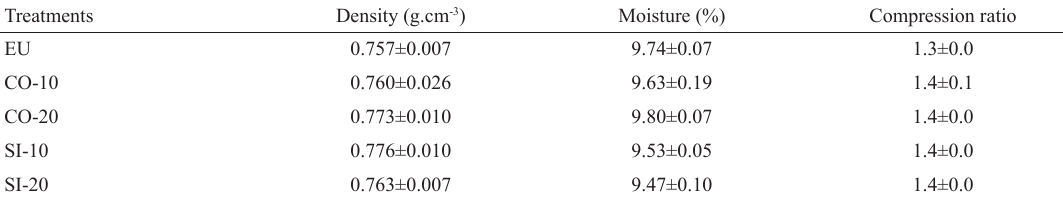
Table 3: Values of the particleboards density, humidity and compression ratio.